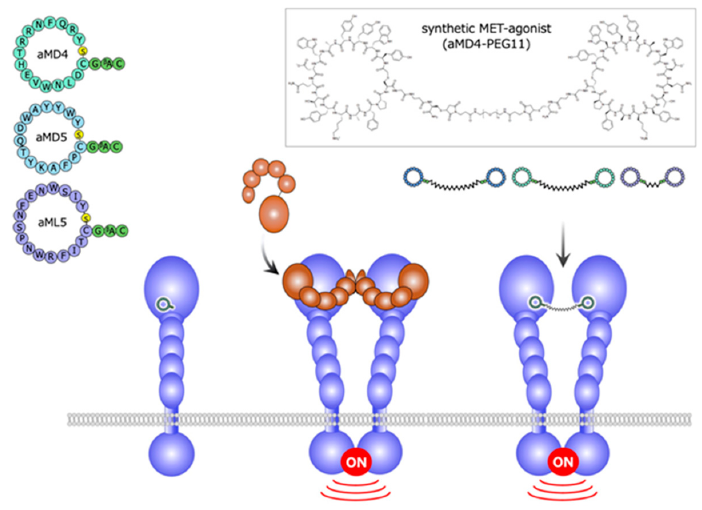
Figure 7. Structures and outline of the activity of a synthetic MET agonist composed of cyclic peptides [25].